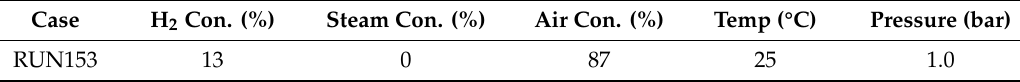
Table 1. Initial condition of the ENACCEF RUN153 Test